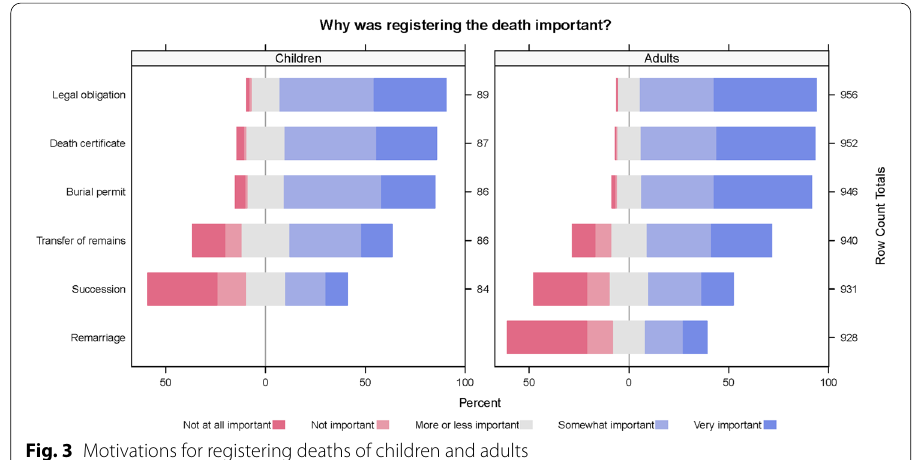
Fig. 3 Motivations for registering deaths of children and